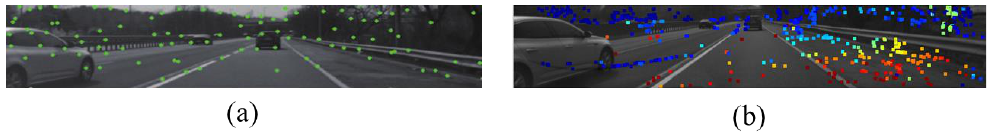
Figure 11. Point selection for VO in the homogeneous environment with moving traffic: ( a ) Selected points using feature matching. ( b ) Selected points using direct